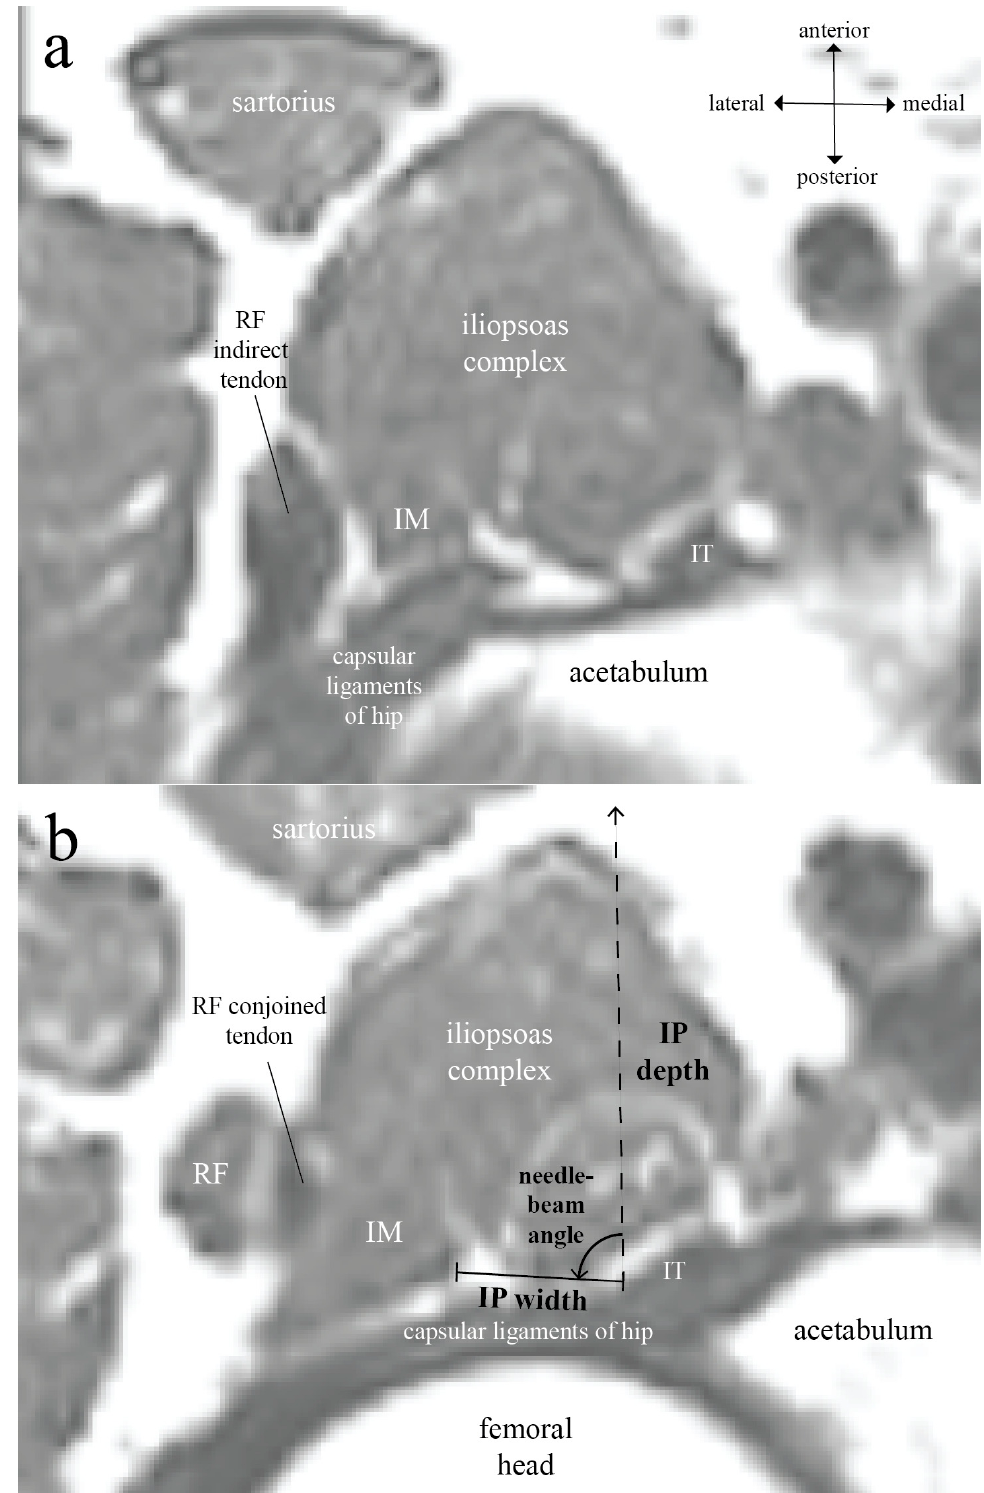
Figure 1. Axial plane of T2-weighted magnetic resonance (MR) images of the human right hip: ( a ) At the level where rectus femoris (RF) indirect tendon appears and extends anteroposteriorly towards acetabular rim; ( b ) At the level 10–15 mm caudal to Figure 1a, where the RF indirect and direct tendon merge into its conjoined tendon, the iliopsoas plane (IP) width, depth, and needle-beam angle were measured. The anterior skin surface used for IP depth measurement is not shown.